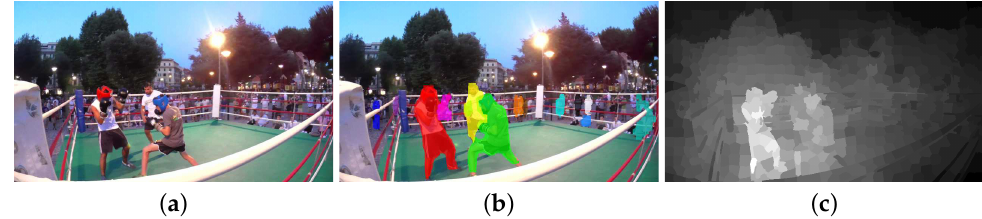
Figure 2. Object instance generation in the “Boxing-fisheye” sequence: ( a ) input frame, ( b ) object instances, and ( c ) foreground